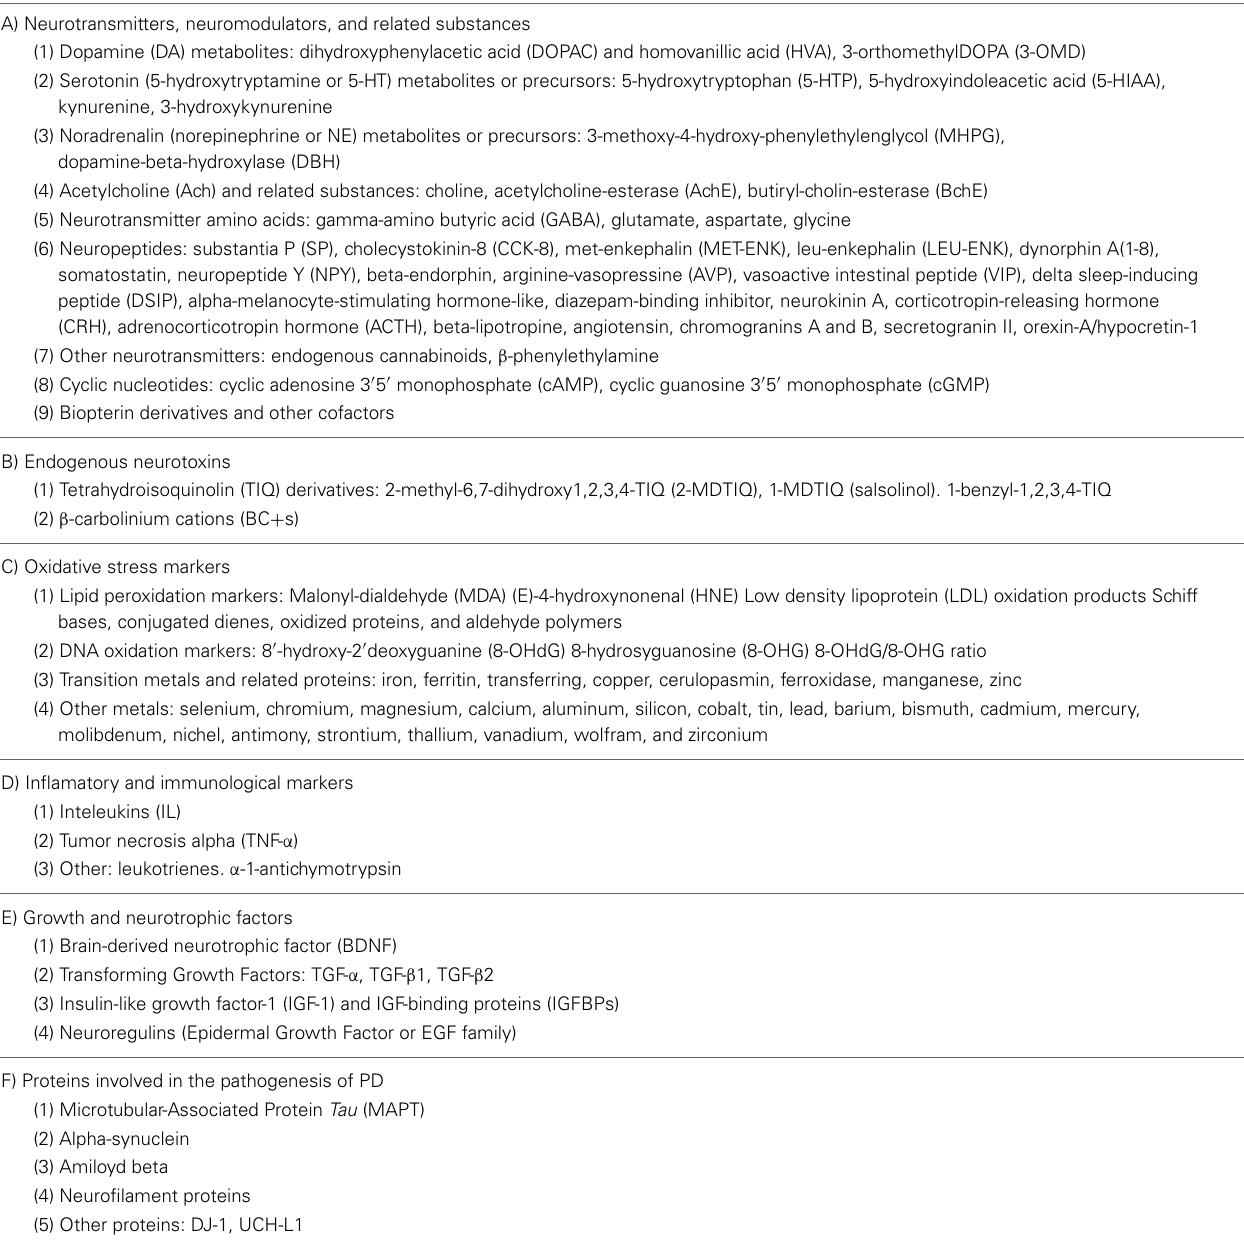
Table 1 | Relation and classification of compounds measured in CSF of